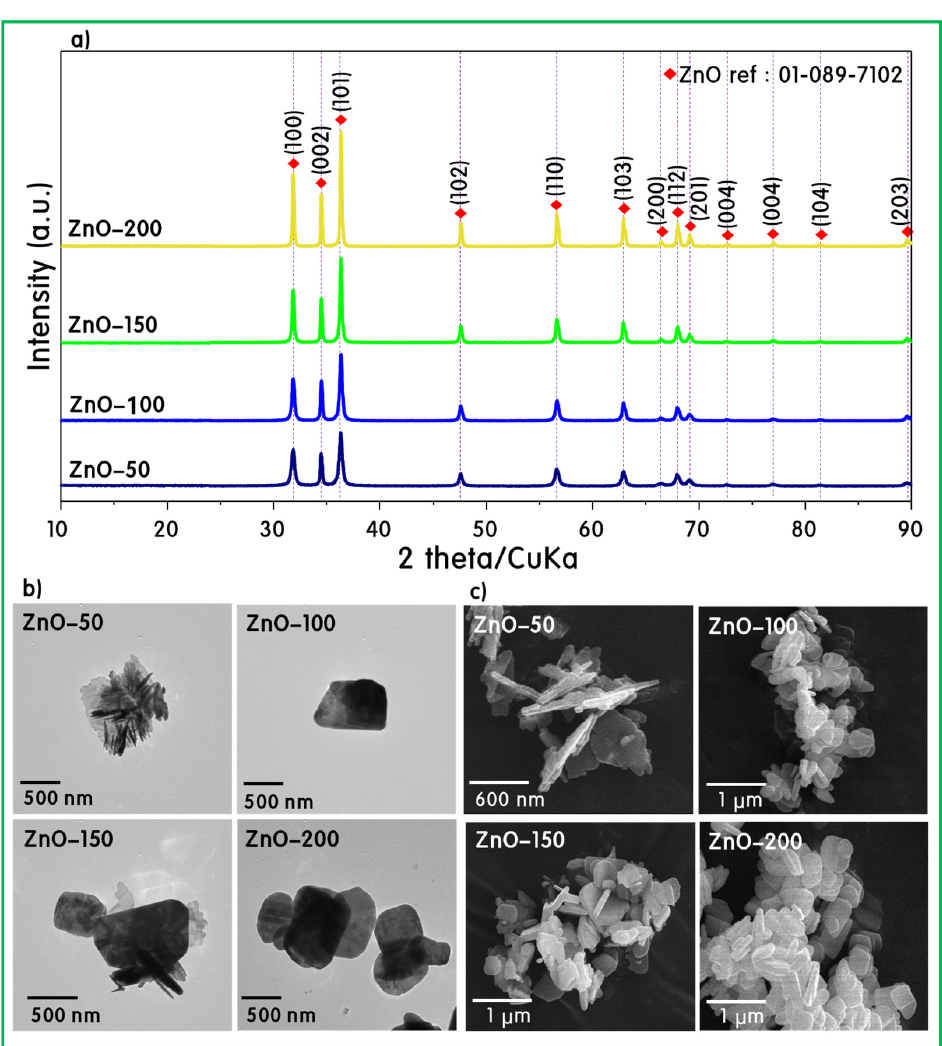
Figure 1. ( a ) XRD patterns, ( b ) TEM images, and ( c ) SEM images for the ZnO nanoplates. Furthermore, the ZnO nanoplate structures were confirmed by the HR-TEM analy- sis presented in Figure 2a. A SAED pattern and corresponding identified lattice fringes associated with ZnO from Figure 2b–d appeared with the interplanar distances of 0.260, 0.162, and 0.141 nm, which are ascribed to the (001), (110), and (200) plane of the ZnO phases. ZnO found a pure type of nanoplates clearly represented by elemental mapping. Figure 2e shows the elements used in the synthesis of ZnO, which are zinc and oxygen.